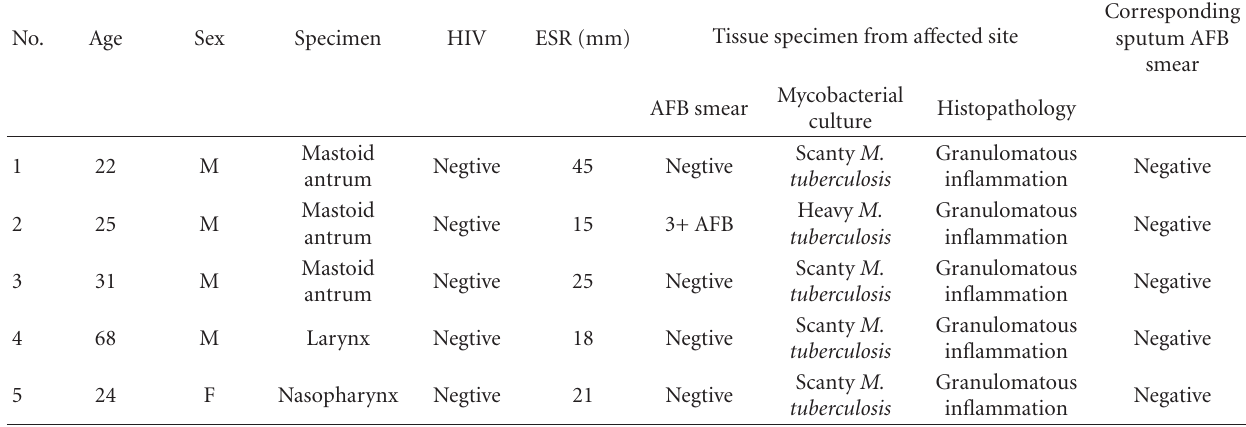
Table 2: Details of five patients with Mycobacterium tuberculosis culture-positive otorhinolaryngeal specimens. No.